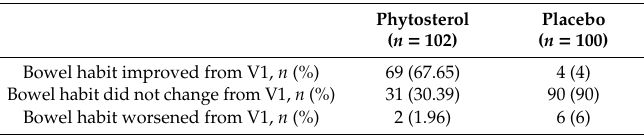
Table 5. Participants’ perception regarding bowel habits at V4 by the group.